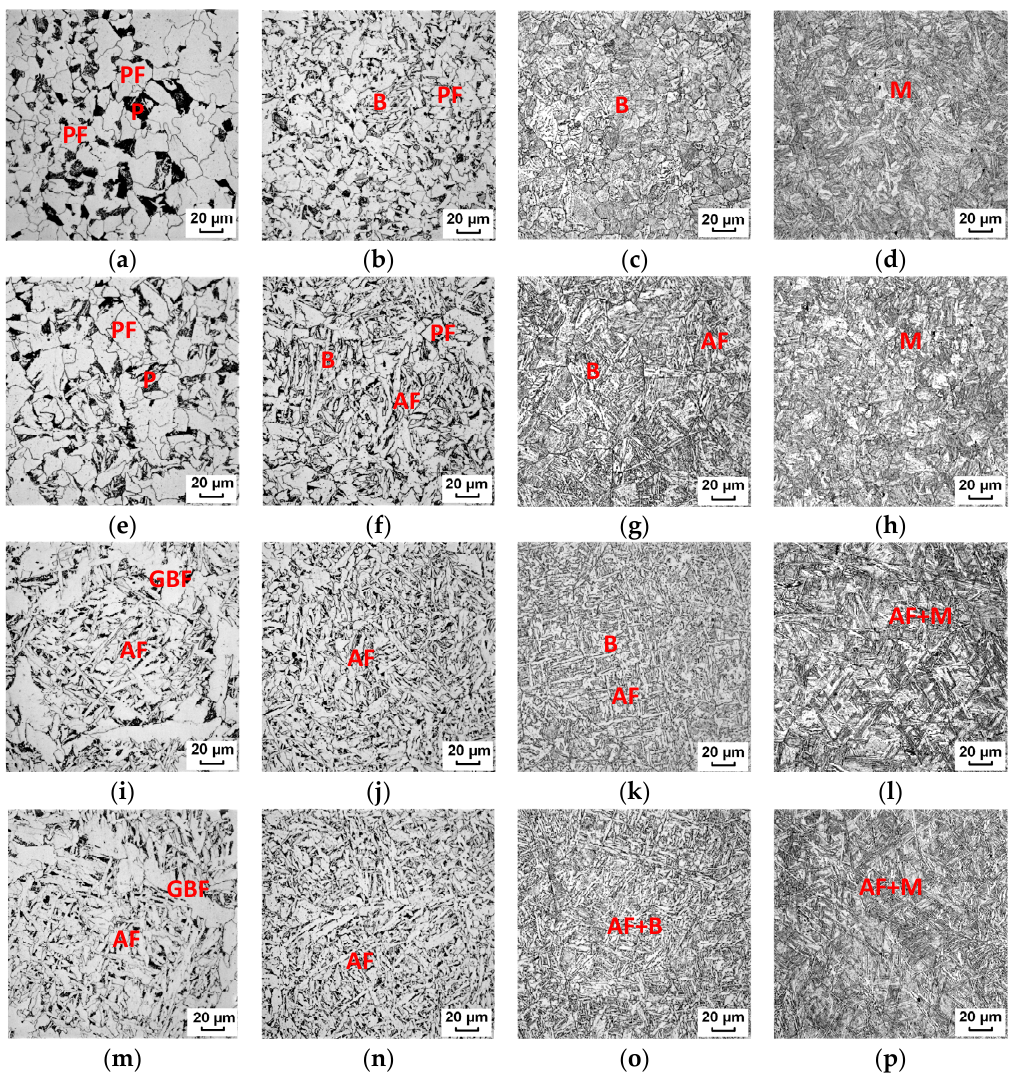
Figure 3. Microstructures formed at cooling rates of ( a , e1 , i , m ) 0.5 ° C/s, ( b , f , j , n ) 1.5 ° C/s, ( c , g , k , o ) 15 ° C/s, and ( d , h , l , p ) 50 ° C/s with austenitization temperatures of ( a – d ) 950 ° C, ( e – h ) 1050 ° C, ( i – l ) 1150 ° C, and ( m – p ) 1250 ° C. PF: Polygonal ferrite; AF: Acicular ferrite; GBF: Grain boundary ferrite; P: Pearlite; B: Bainite; M: Martensite.